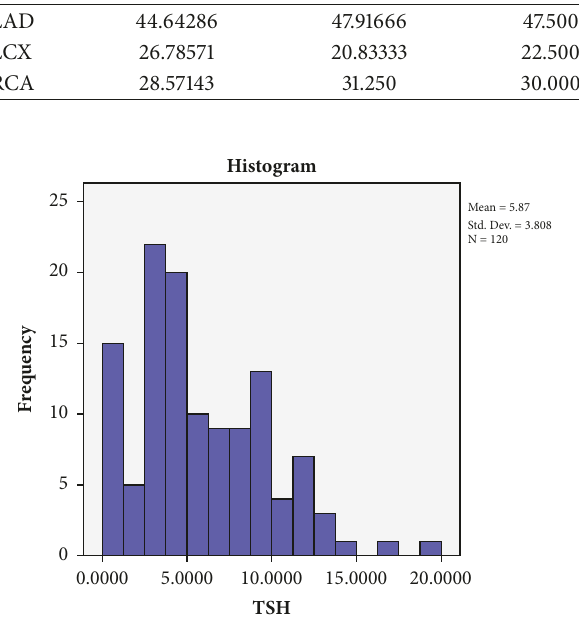
Figure 1: Distribution of TSH in blood in study population (n=168).